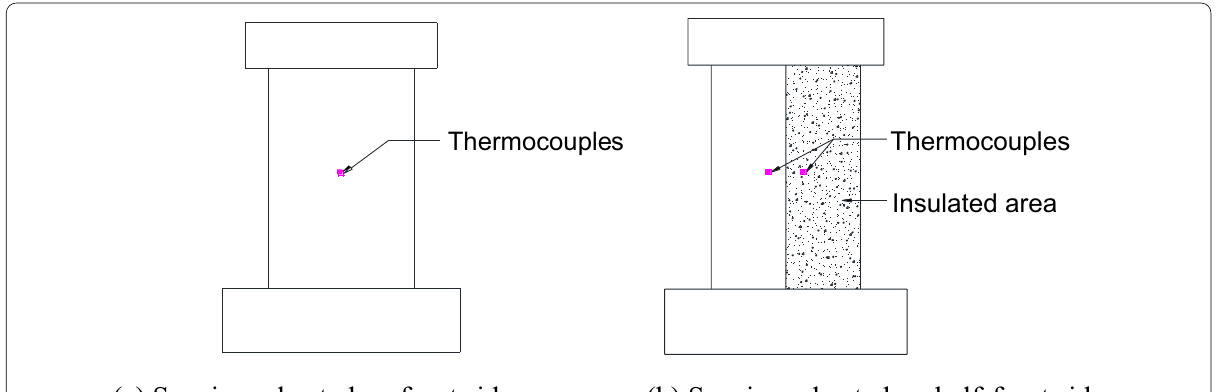
Fig. 3 Location of thermocouples.